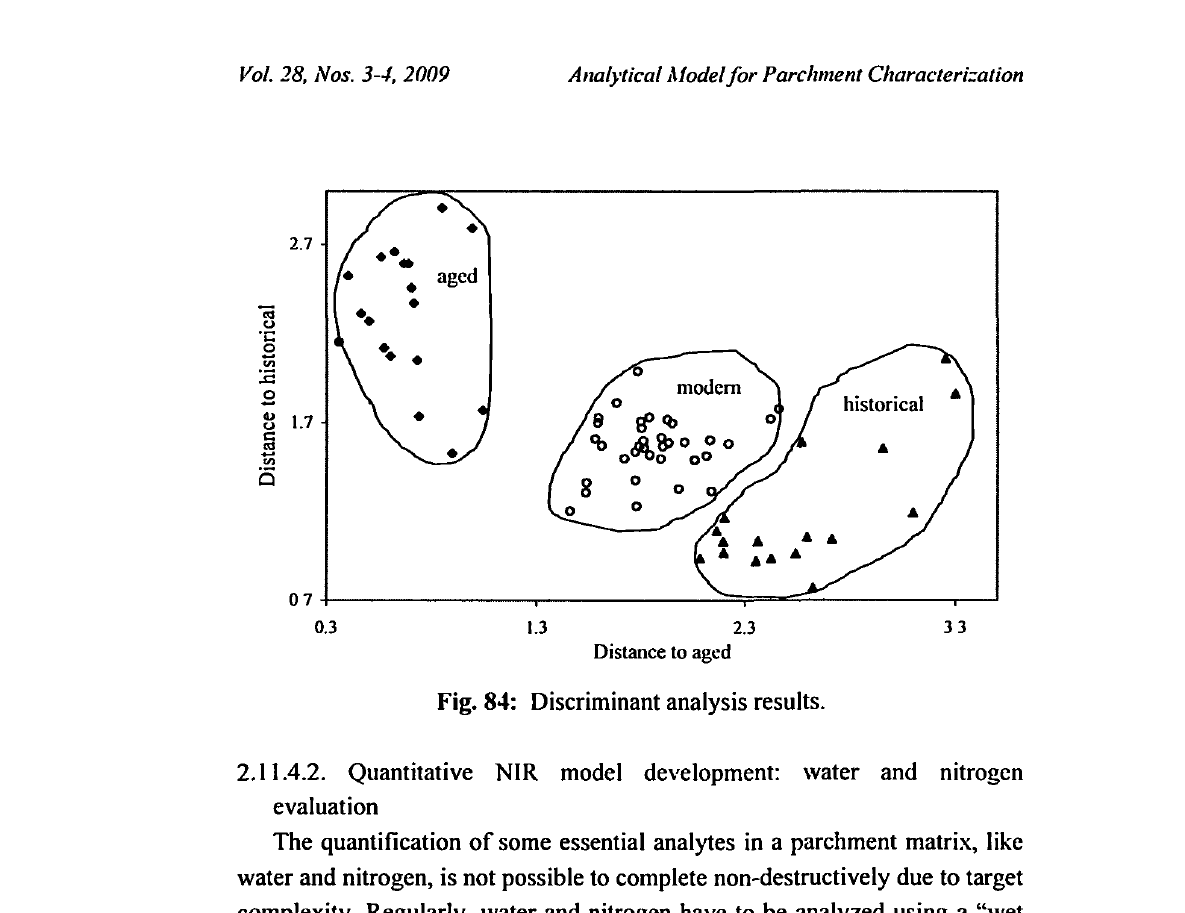
Fig. 84: Discriminant analysis